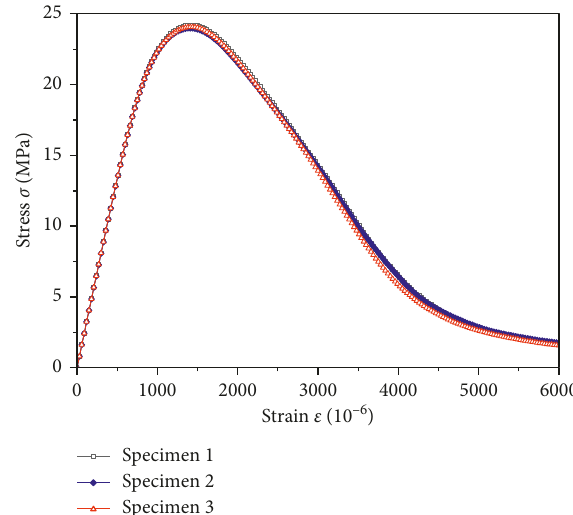
Figure 19: Macrocompressive stress-strain curve of concrete with different aggregate